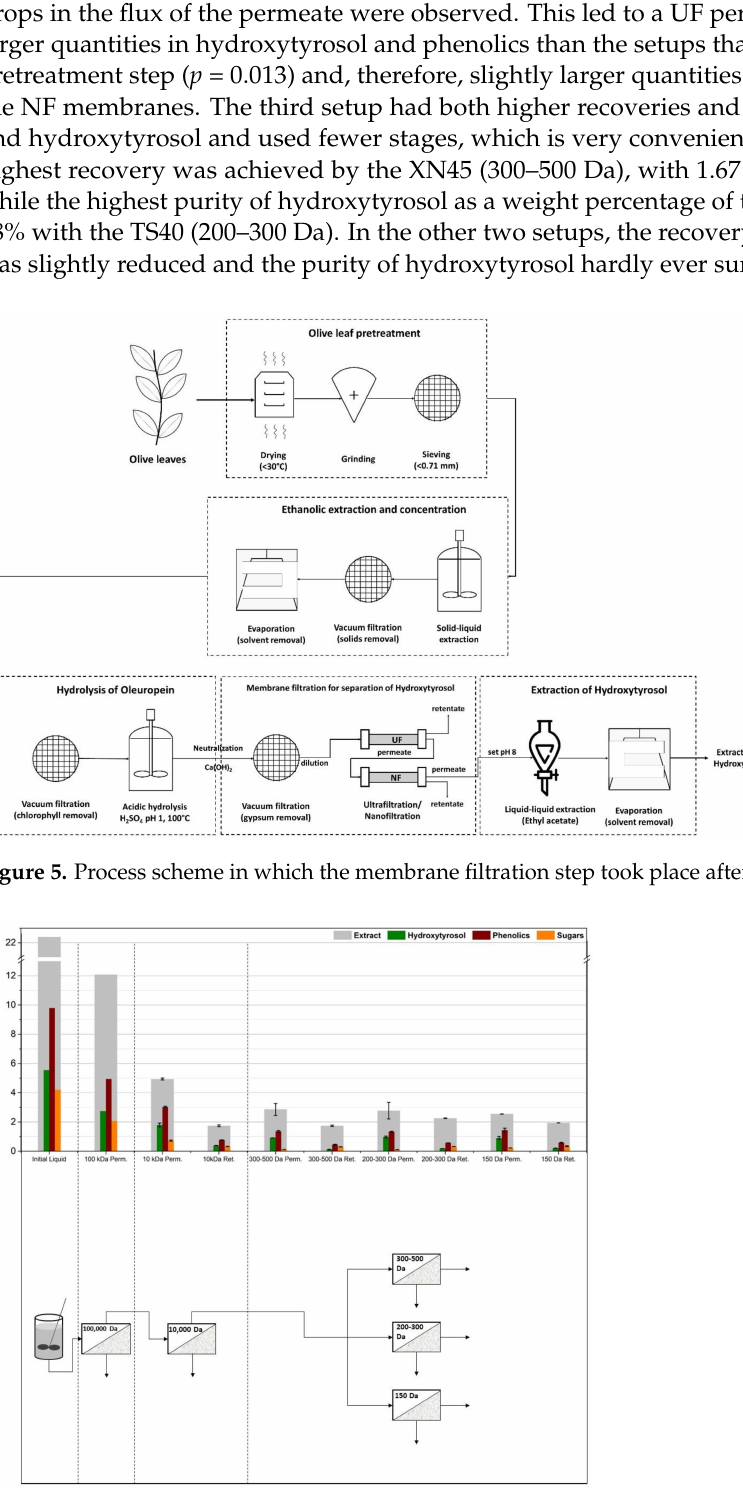
Figure 6. The first membrane treatment scheme: two ultrafiltration steps (US100, UP010) were used in line and the permeate from the 10,000 Da membrane was split into three equal parts and was treated with three different nanofiltration membranes (XN45, TS40,